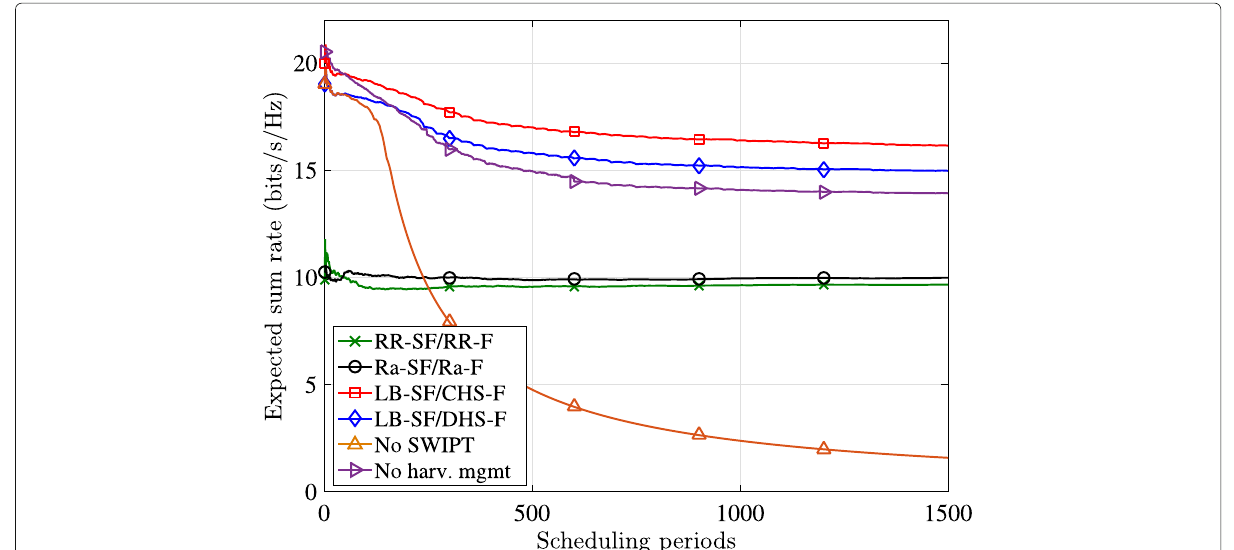
Fig. 5 Time evolution of the average sum rate. Time evolution of the average sum rate of the system for the different